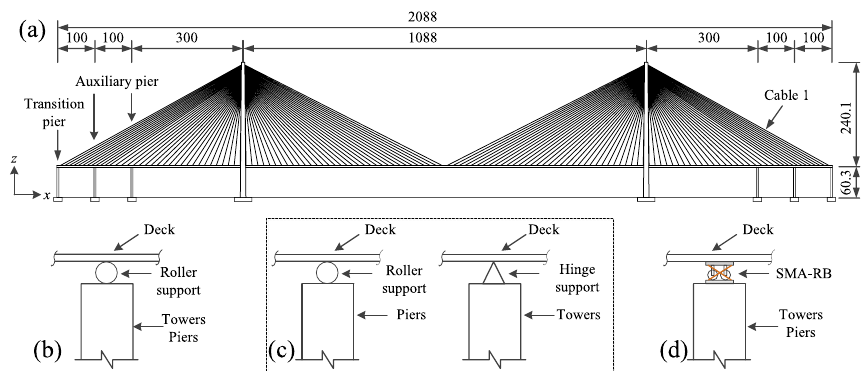
( c ) Rigid system (RS), and ( d ) SMA-RB system